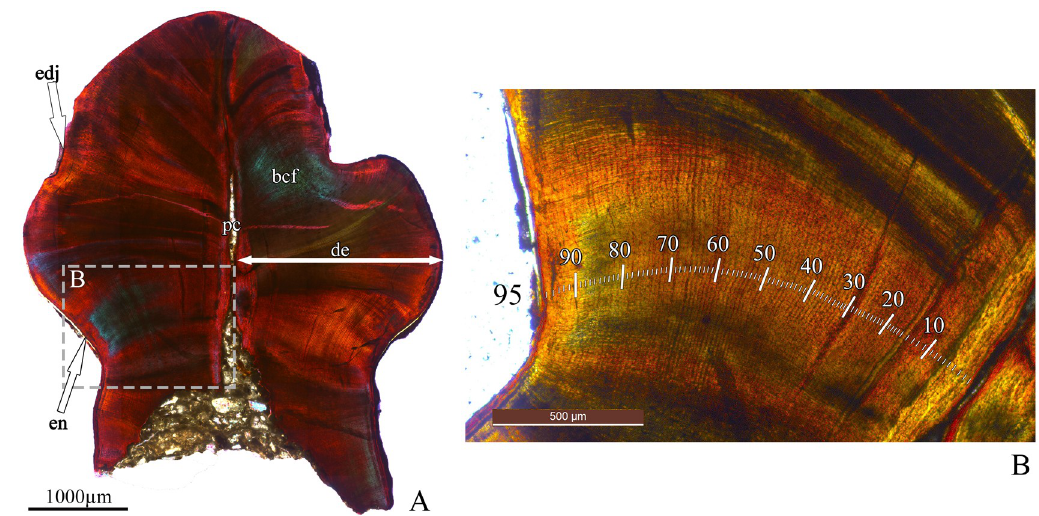
Fig 13. Dental histology of Stegosauria indet. from the Teete locality, Yakutia, Russia; Batylykh Formation (Lower Cretaceous). Thin sections of the specimen ZIN PH 41/246. Coronal section under polarized light with lambda waveplate (A) and close-up of coronal section under normal light (B) showing incremental lines of von Ebner (indicated by white stripes). Abbreviations: en, enamel; de, dentin; cp, pulp cavity; edj, enamel-dentin junction; bcf, bundles of collagen fibres.